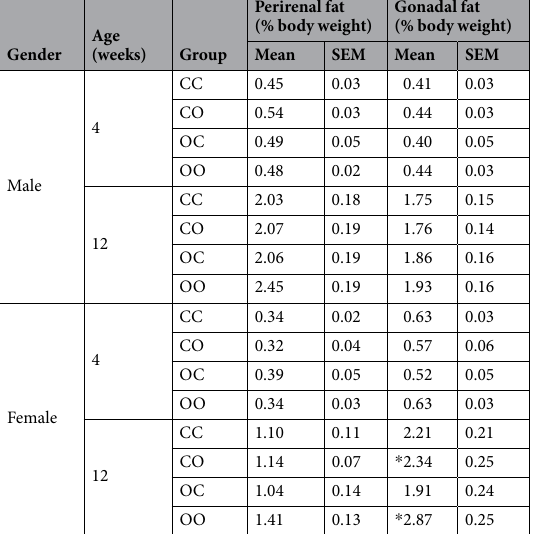
Table 1. Offspring adiposity. Values are for mean and SEM. Offspring adipose tissue mass of four groups of cross-fostered offspring at 4 or 12 weeks of age: offspring exposed to a chow diet during gestation cross-fostered to a chow fed dam during lactation (CC, n 15–16) or a cafteria fed dam (CO, n 16), offspring exposed to a cafeteria diet during gestation cross-fostered to a chow fed dam during lactation (OC, n 16) or a cafeteria fed dam (OO, n 12). Effect of sex for gonadal and perirenal adiposity at 4 and 12 weeks of age ( P < 0.05). * Effect of maternal lactation diet ( P =